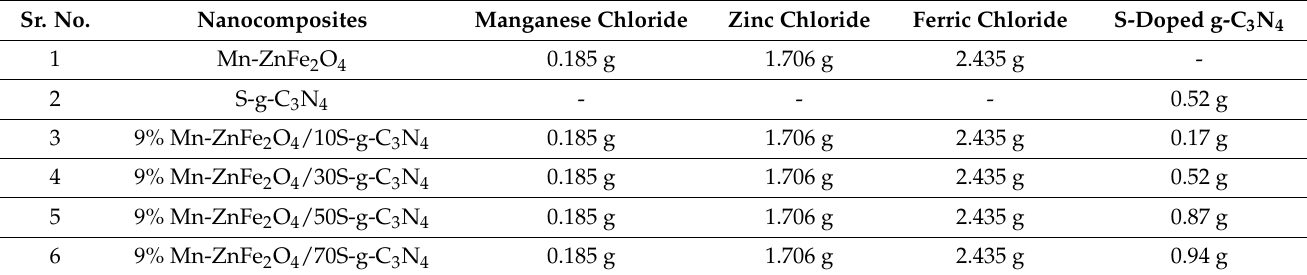
Table 1. Composition of the synthesized Mn-ZnFe 2 O 4 /S-g-C 3 N 4 composites. Sr.